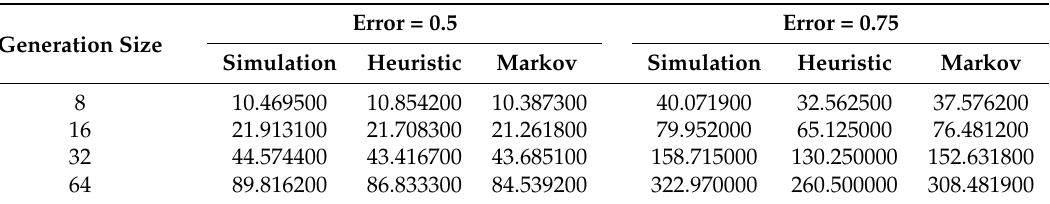
Figure 6. Average number of transmissions in all links in cache coding. Table 1. Total number of transmission rounds in cache coding.